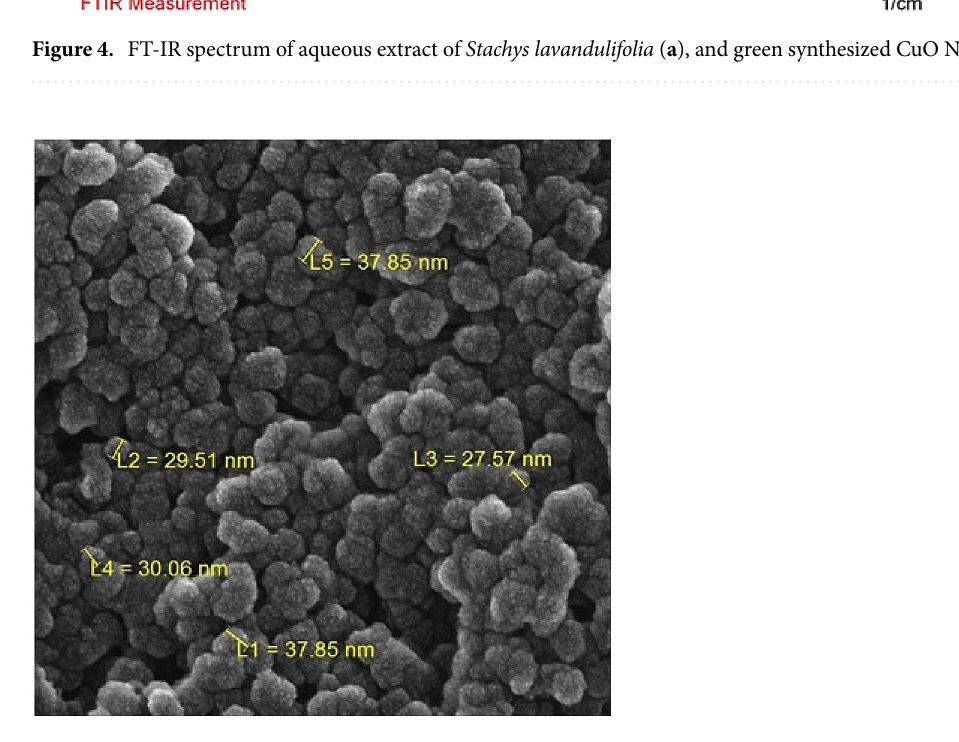
Figure 5. FE-SEM study of biogenic CuO